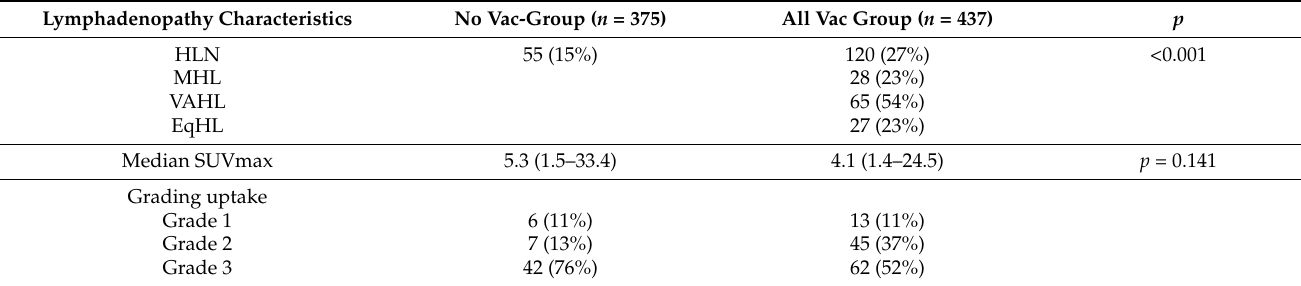
Table 2. Frequency of risk classes and SUVmax grade groups in No Vac- and Vac-group. Lymphadenopathy